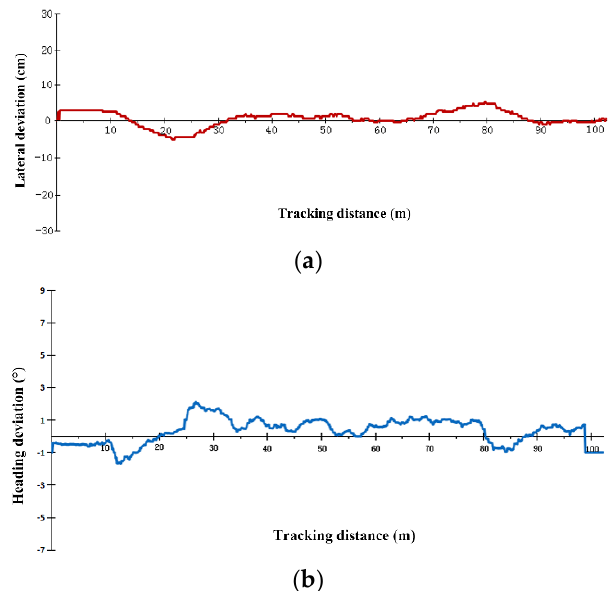
Figure 11. Path tracking error using proposed control algorithm. ( a ) Lateral deviation; ( b ) heading deviation.